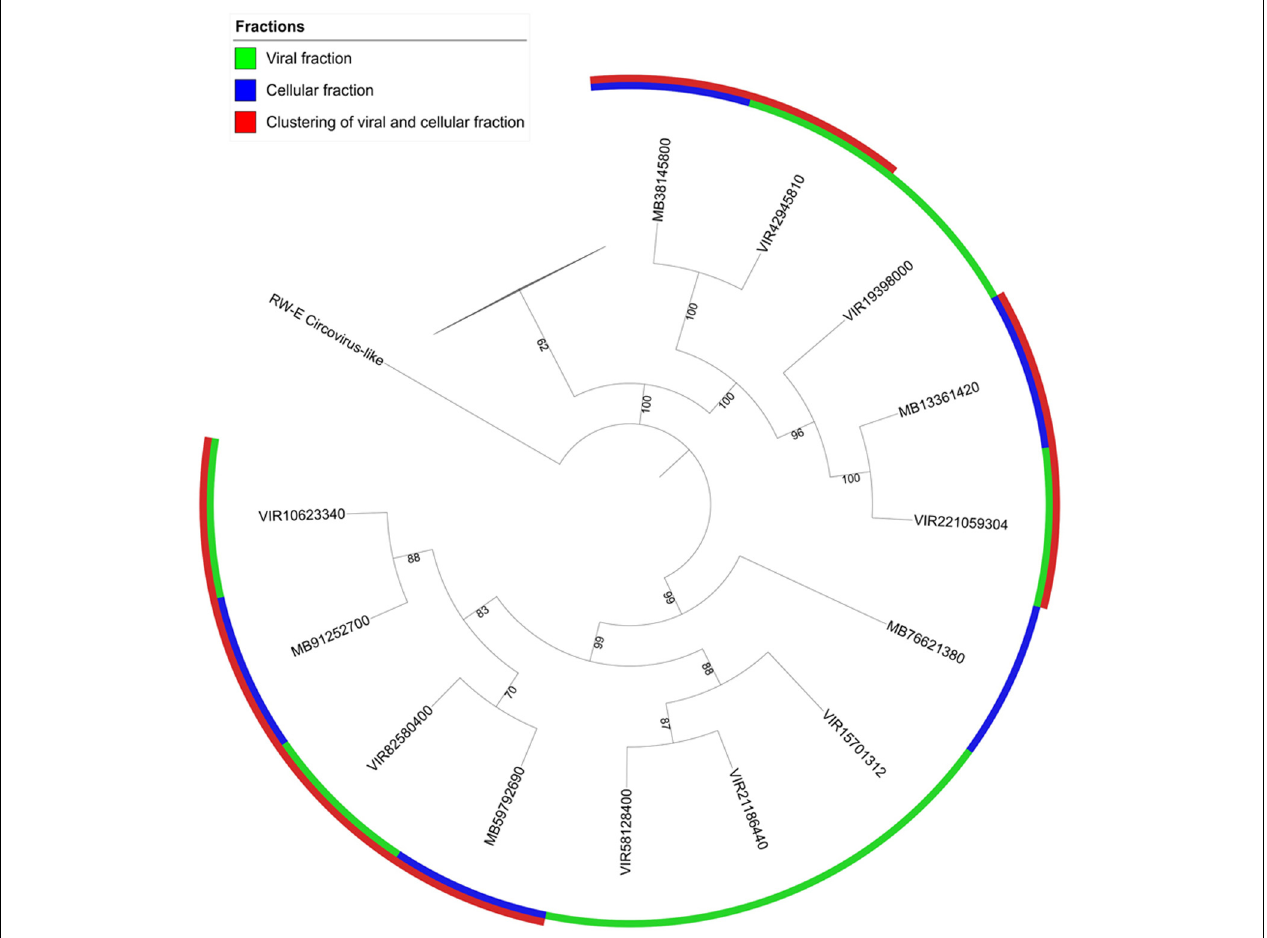
FIGURE 4 | Phylogenetic analysis of microbial and viral fractions from Shark Bay stromatolites for the Replication-associated protein (Rep) in CRESS viruses. Maximum likelihood phylogenetic tree of Rep protein sequences found in CRESS viruses in Shark Bay stromatolites. Protein sequence alignments were performed using MUSCLE and gaps in alignment were removed with UGENE. The tree was constructed with IQ-TREE v. 1.6.1 with 1000 bootstrap replicates and was visualized with iTOL. Number indicates bootstrap values, nodes with bootstrap values lower than 70 were not shown and represented by the collapsed branch. The collapsed branches in this figure represent reference sequences from Rosario et al. (2009a) for the replication (rep) protein that have lower than 70 bootstrap values.